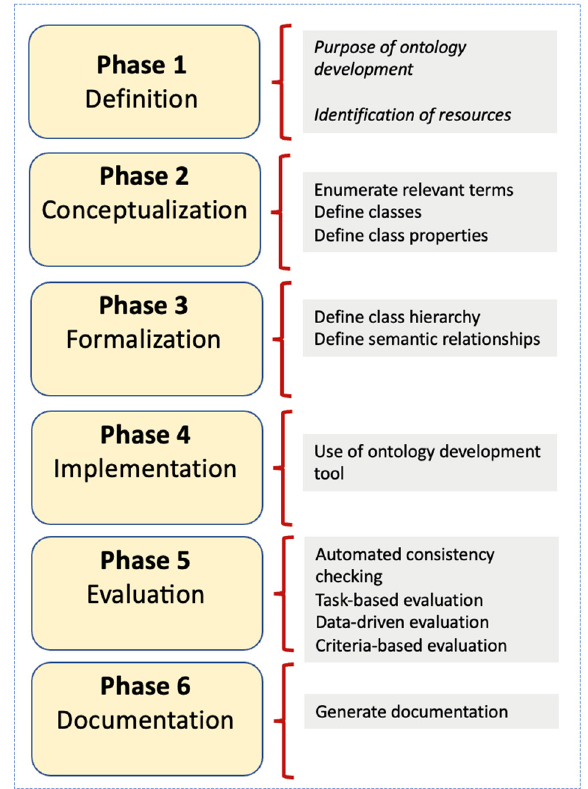
Figure 1. Research method. Source: Elaborated by the authors based on (Badr et al. 2013).